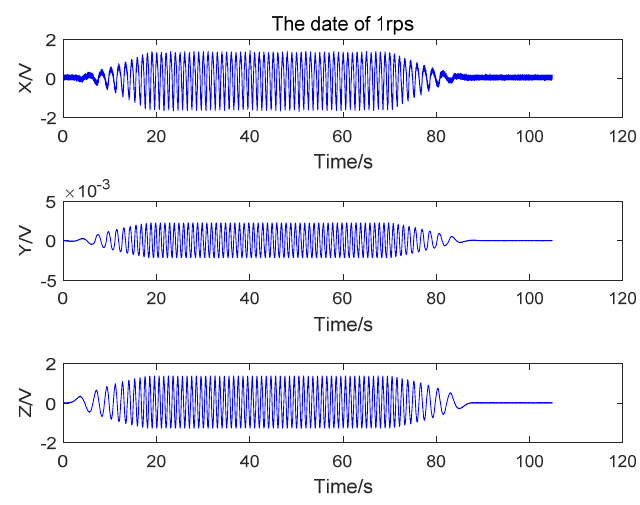
Figure 6. Sensor induction voltage when the rotary table intermediate coil rotation rate is 1 rps. As is apparent from Figure 7, the sensor read an angular rate of 1.013–1.018 rps when the rotary table stabilized at 1 rps, producing an error of 1.3‰–1.8‰ FS; the initial angular rate measurement error was greater, which is explained by unstable measurement of zero ‐ crossing signal at the initial stage.